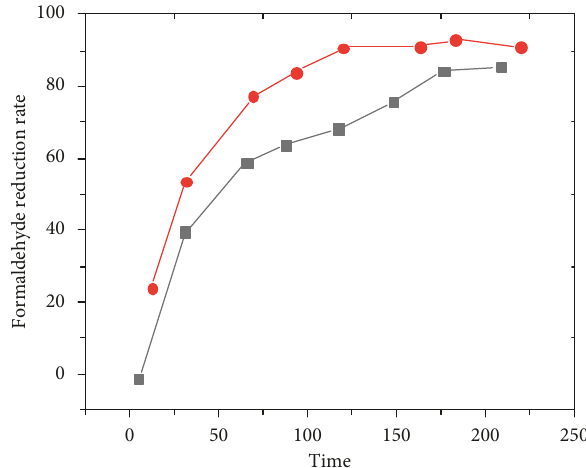
Figure 6: Influence of different nano-TiO degradation rate of photocatalytic